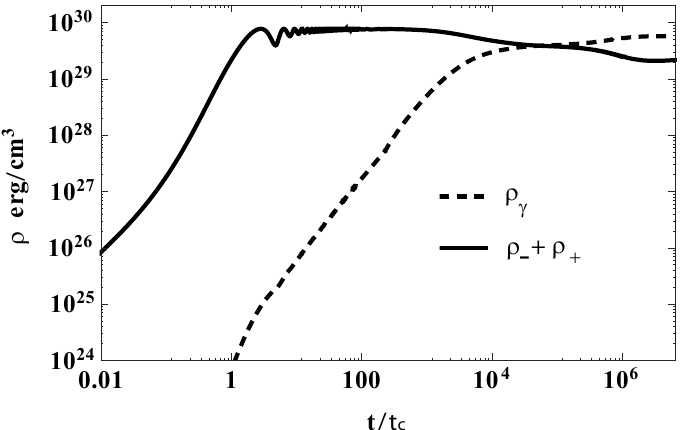
Figure 7. Energy densities of pairs and photons obtained from the numerical solution of Equations (33) and (35) with initial field E 0 = 100 E c Figure 12.3 Energy densities of pairs and photons obtained from the nu- merical solution of Eqs. (12.12) and (12.14) with initial field E Reprinted from [289] c 2013, with permission from Elsevier. (cid:13)